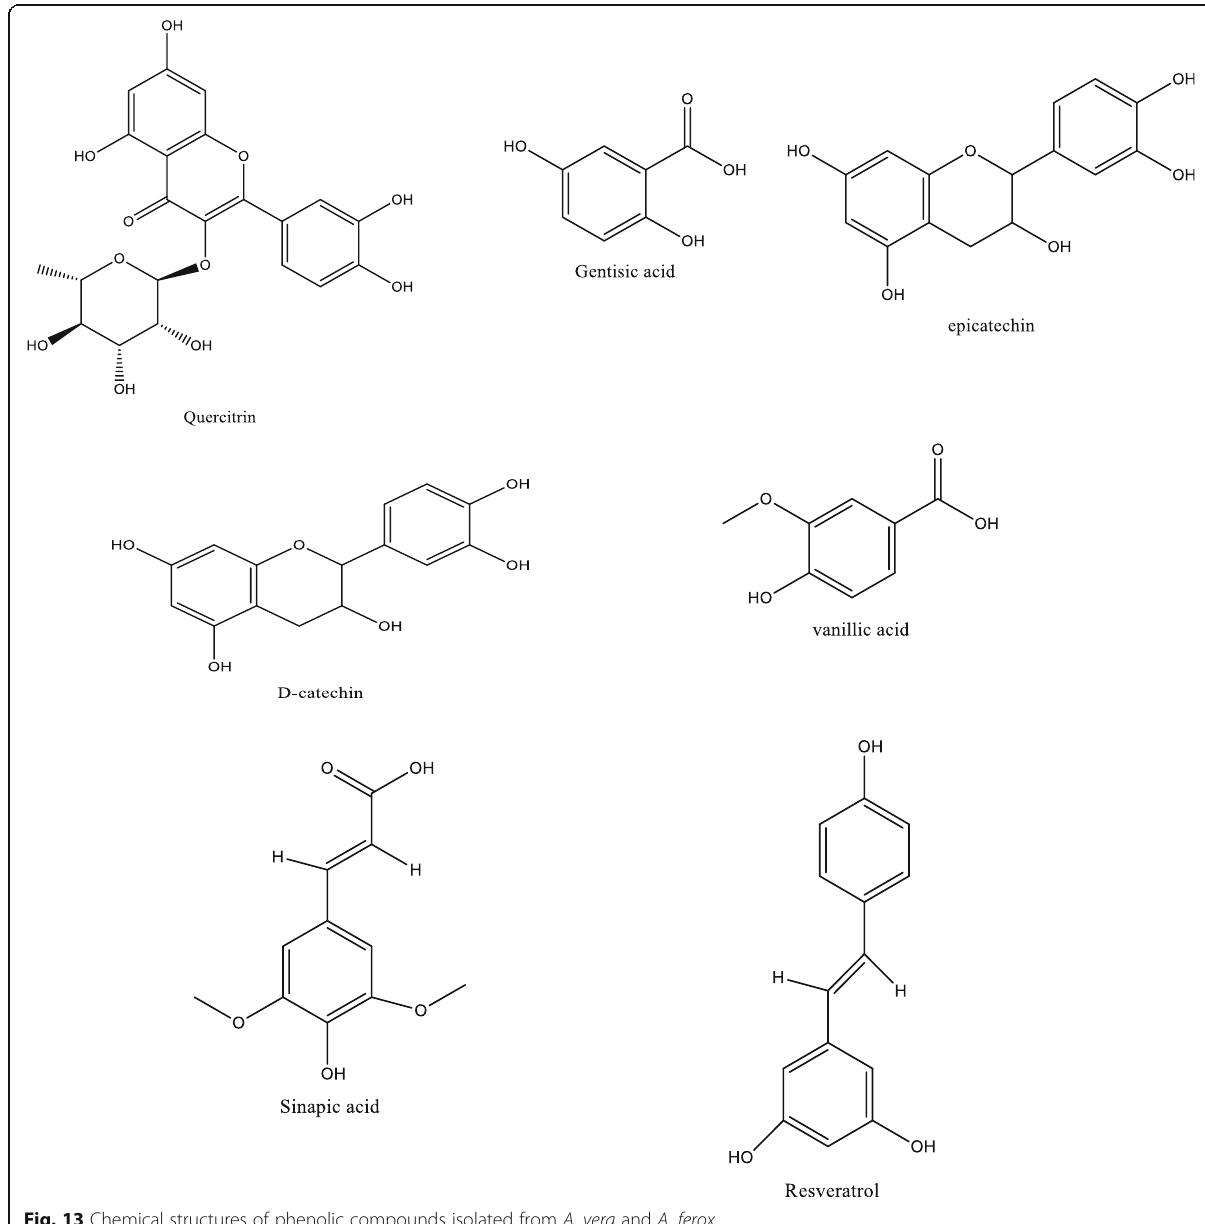
Fig. 13 Chemical structures of phenolic compounds isolated from A. vera and A.